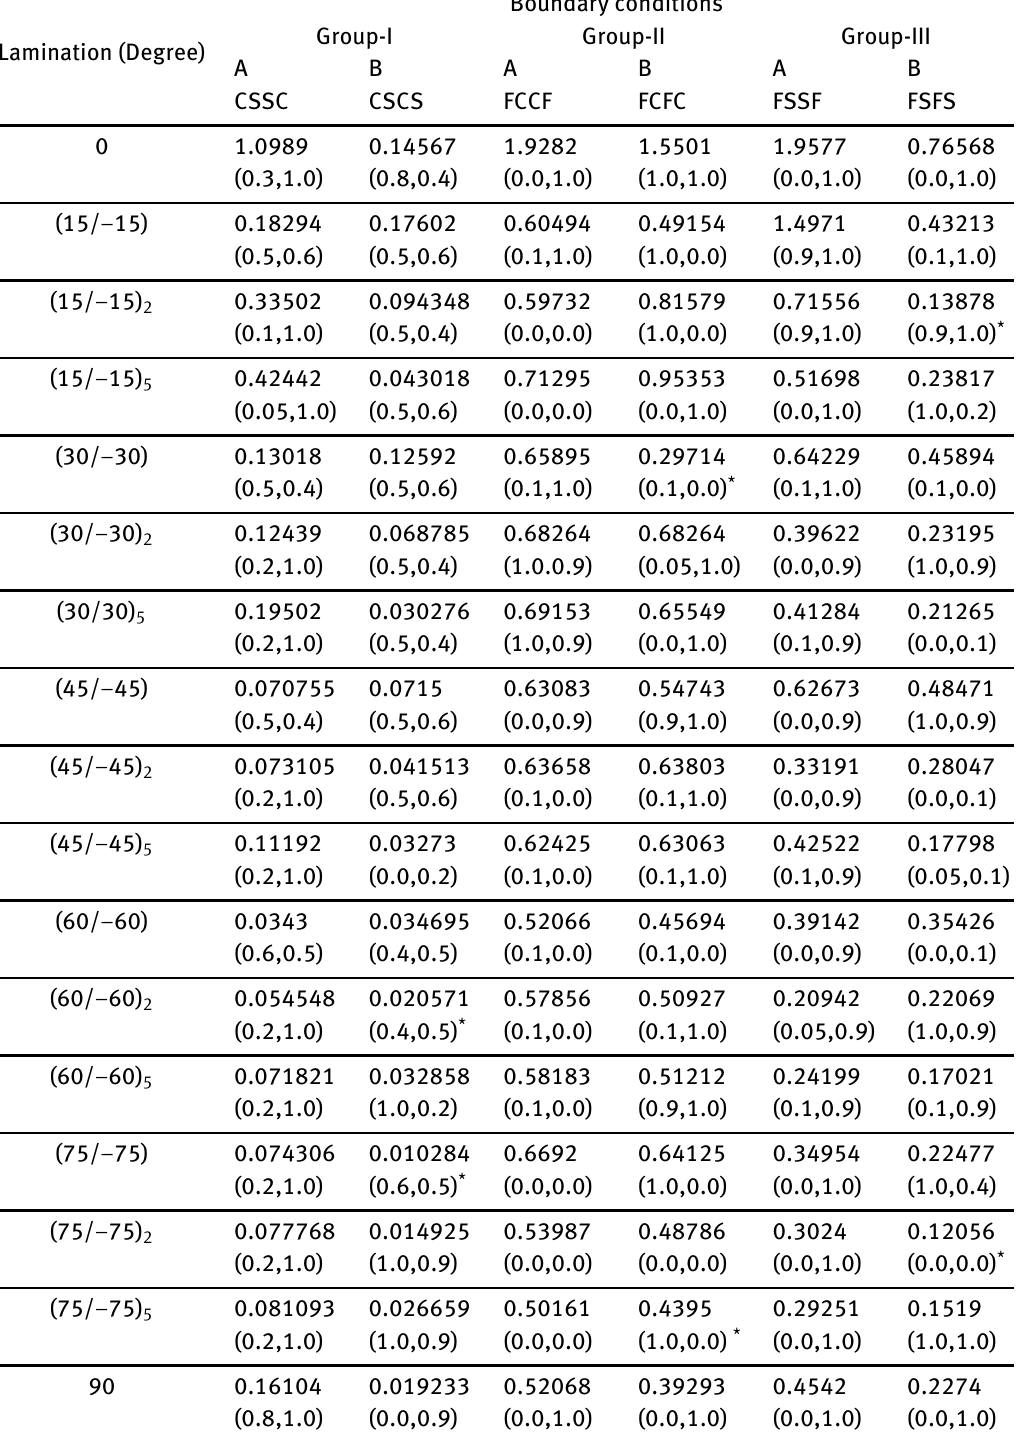
Table 12: Values of maximum non-dimensional hogging moments (+ M y ) x 10 2 for different antisymmetric angle ply lamination and boundary conditions of stiffened composite hypar shell with